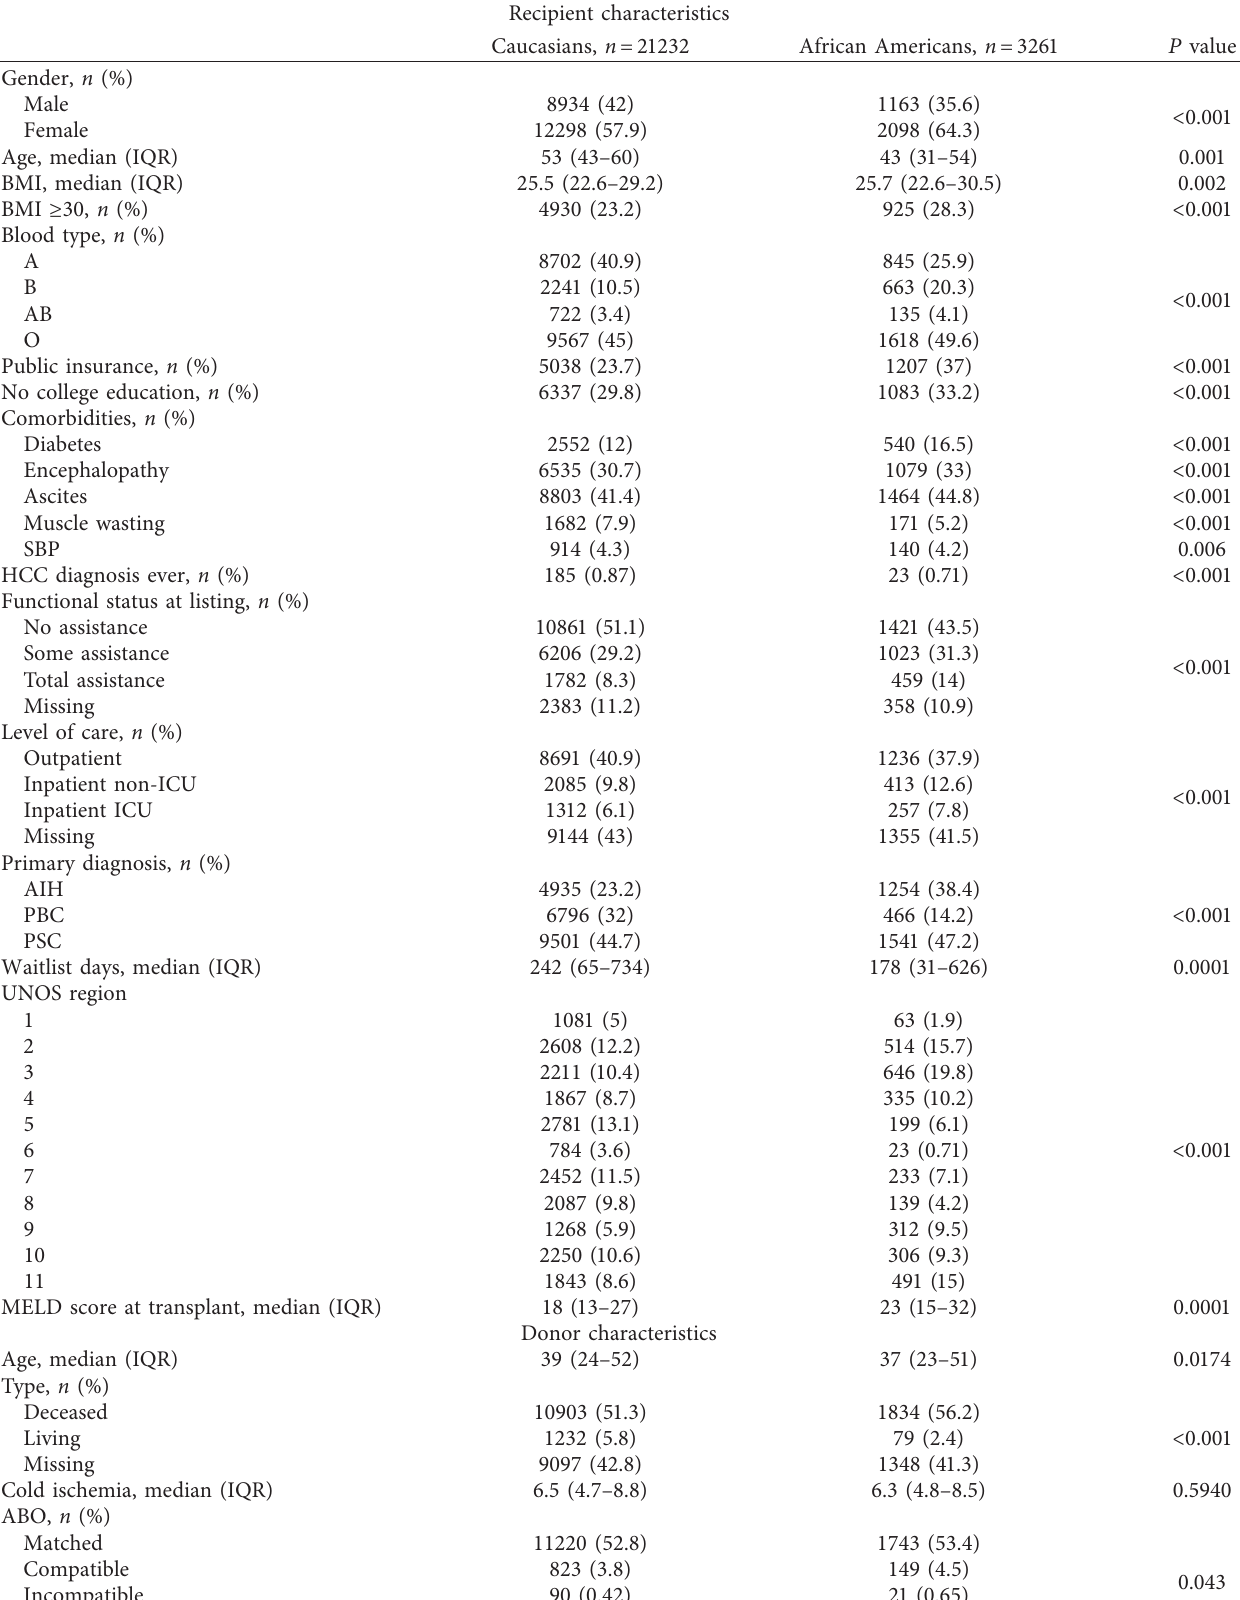
Table 1: Baseline